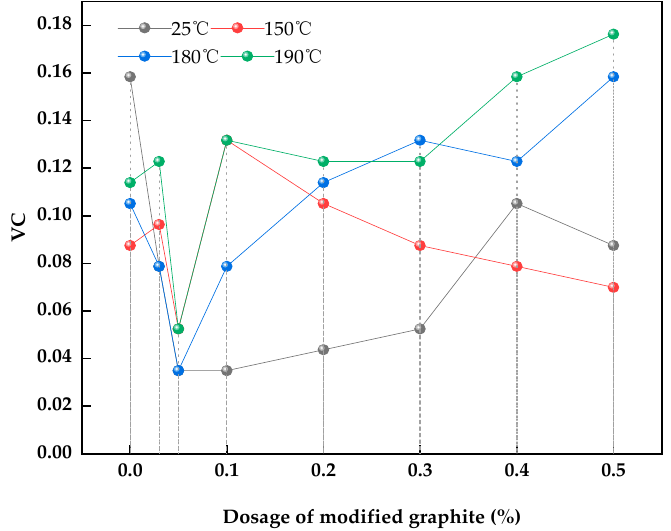
Figure 6. Relationship between the addition of different dosages of modified graphite and the viscosity coefficient.